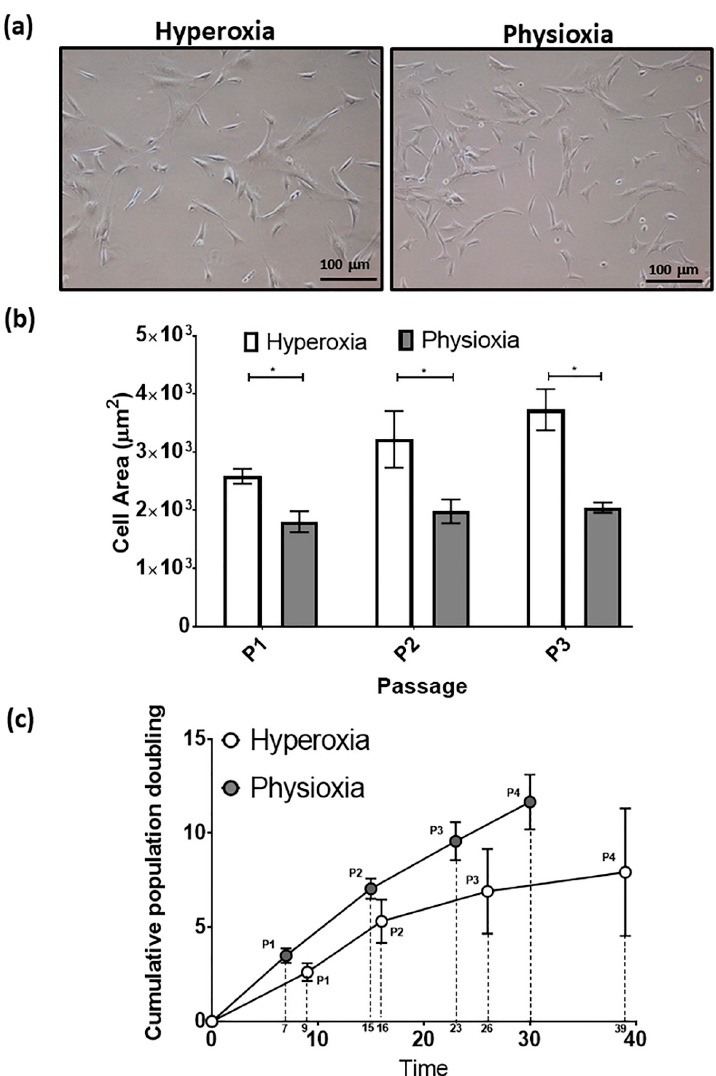
Figure 4. ( a ) Photomicrographs of rabbit MSCs cultured under hyperoxia and physioxia. ( b ) Cell area measurements for individual MSCs from photomicrographs (10 individual cells measured per image) and ( c ) cumulative cell growth of MSCs under physioxia and hyperoxia. Data represent mean ± S.D.; n = 8; * p < 0.05.